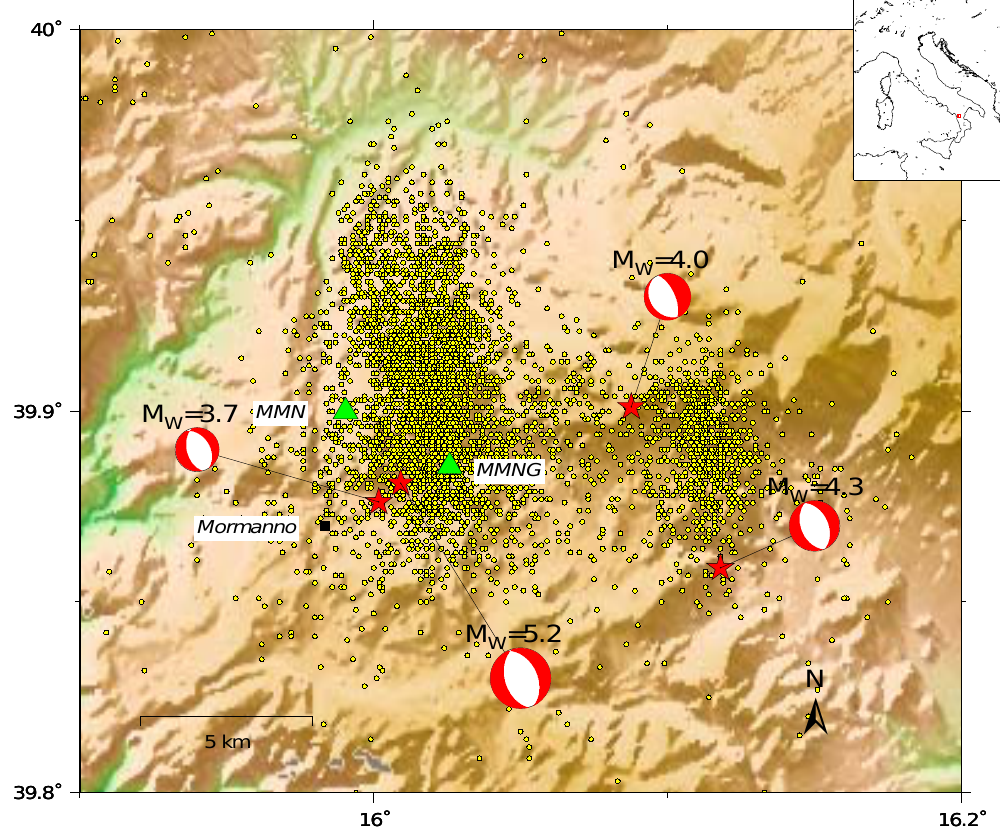
Figure 1. Geographical setting of the study area located in the Calabria peninsula, southern Italy (see inset). Green triangles show the location of a radon monitoring stations MMN and MMNG. Yellow circles represent the earthquakes recorded by ISIDe (2010) between December 2011 and October 2014 with epicentral distance from MMN (the older station) less than or equal to 15km (4800 events). Focal mechanisms of the Mw4.3 28 May 2012, Mw5.2 25 October 2012, Mw3.7 4 June 2014 and Mw4.0 6 June 2014 earthquakes (http: //cnt.rm.ingv.it/tdmt.html) are also